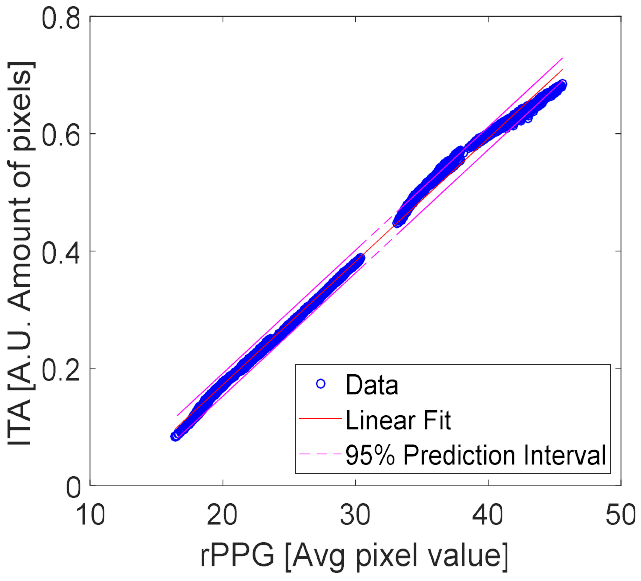
Figure 18. Linear regression of rPPG and ITA data with a 95% prediction interval. Table 4. Linear regression statistics of rPPG vs. rSPG data with a 95% prediction interval.